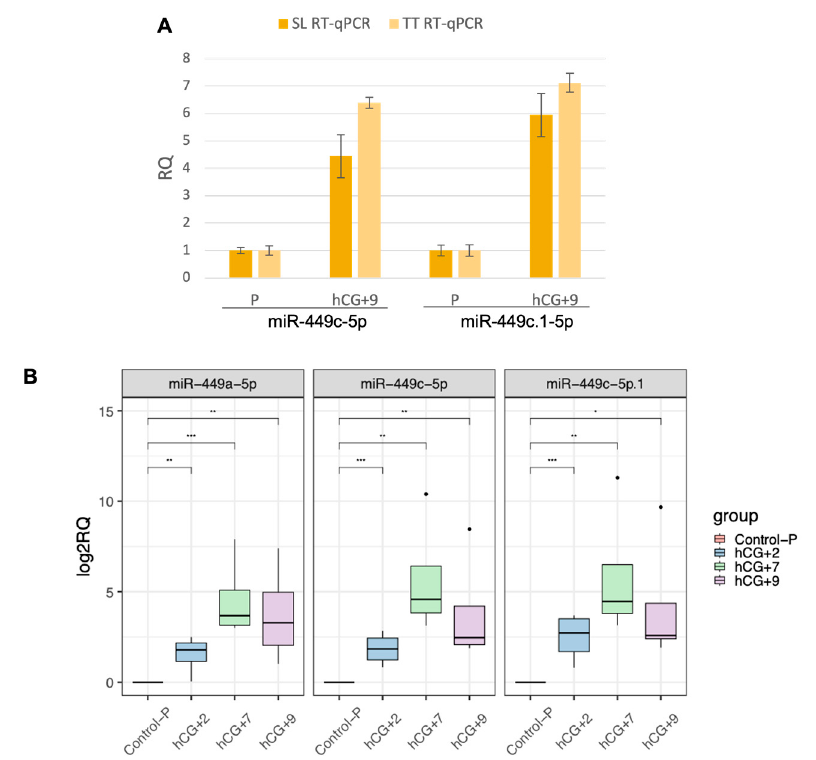
Figure 2. Expression of the mir-449 family throughout the endometrial cycle. ( A ) Relative quantity of miR-449c and miR-449c.1 analyzed using stem-loop (SL) RT-qPCR and two-tail (TT) RT-qPCR in one patient; error bars represent standard deviation of three technical repeats. ( B ) Relative expression levels of miR-449a, miR-449c, and miR-449c.1 analyzed using SL RT-qPCR in the patient cohort hCG + 2, hCG + 7 and hCG + 9 compared to proliferative phase (control-P). Expression changes among the groups were compared using one-way ANOVA and unpaired t-test (* p < 0.05; ** p < 0.01; *** p < 0.001); boxes span the 25th to 75th percentiles, whiskers extend to the 10th and 90th percentiles, and dots indicate